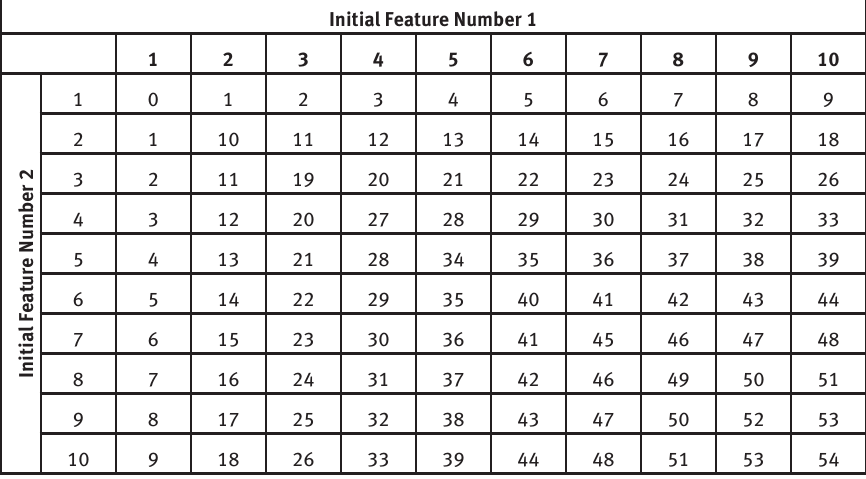
Table 2. Mapping from Primary (1) and Secondary (2) Initial Feature Numbers to